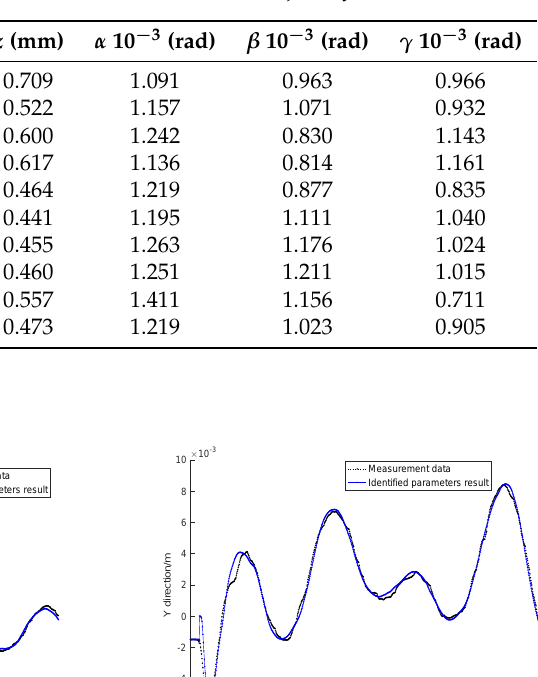
Table 4. The RMS levels of the ten validation trajectory errors.